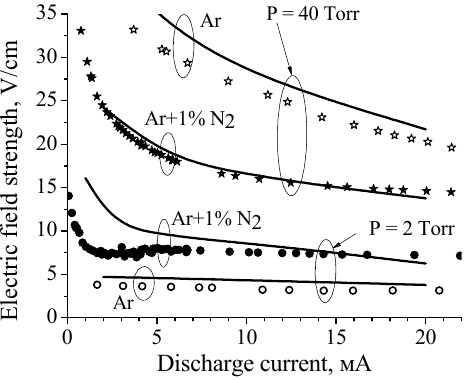
Figure 3. Calculated (curves) and measured (symbols) dependences of the electric field in the positive columns of discharges in pure argon and the Ar + 1%N 2 mixture on the discharge current for P = 2 Torr and 40 Torr [17].